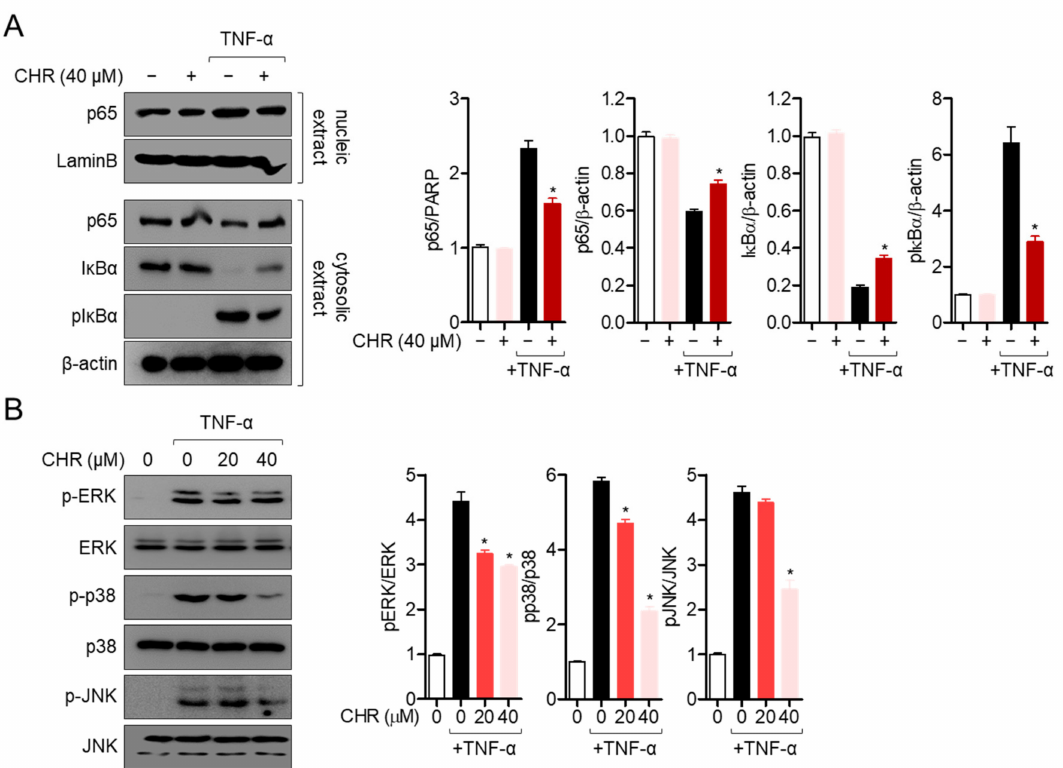
Figure 3. Pre-treatment with chrysophanol mitigates p65 translocation and the mitogen-activated protein kinase (MAPK) pathway in activated HT-29 cells. ( A ) Starved HT-29 cells pre-treated with 40 µ M of chrysophanol for 1 h were stimulated with 10 ng/mL of TNF- α for 1 h. Nucleic extract was separated from whole lysate by using a NE-PER kit. The indicated proteins were detected and normalized with the levels of LaminB (nucleic extract) or β –actin (cytosolic extract). ( B ) Starved HT-29 cells pre-treated with the indicated concentration of chrysophanol for 1 h were stimulated with 10 ng/mL of TNF- α for 30 min. The phosphorylation levels of the indicated proteins were detected and normalized with the levels of total proteins indicated. The mean value of three experiments ± SEM is presented. * p < 0.05 compared with TNF- α -treated cells. I κ B α ; inhibitor of NF- κ B, pI κ B α ; phosphorylated inhibitor of NF- κ B, p-ERK; phosphorylated extracellular signal-related kinase, ERK; extracellular signal-related kinase, p-JNK; phosphorylated c-Jun N-terminal kinase, JNK; c-Jun N-terminal